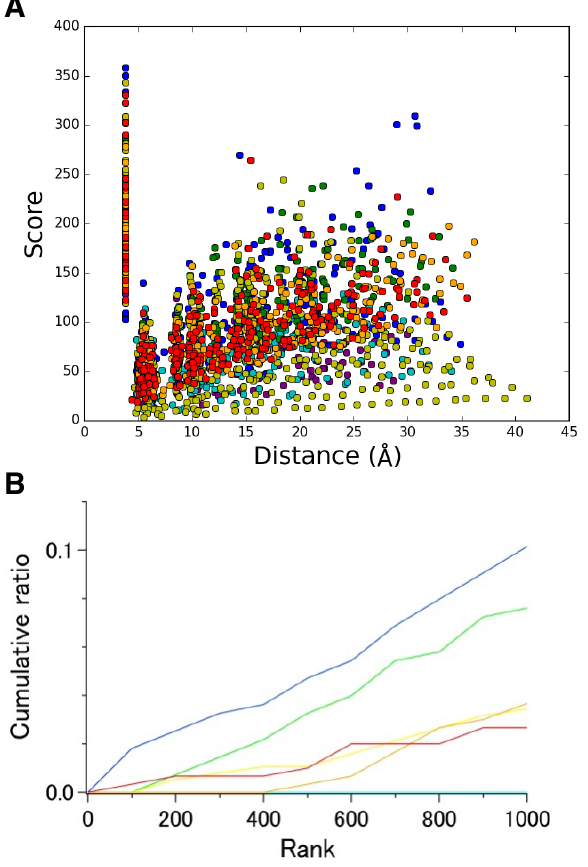
A Figure S4. DSA results for 1,992 intrahelical pairs in set 2. ( A ) Correlation between score and average distance. ( B ) Cumulative ratio of the number of C −C pairs in the top-ranked 1,000. The pairs are colored as follows; purple, helix A; blue, helix B; cyan, helix C; green, α α helix D; yellow, helix E; orange, helix F; red, helix G.